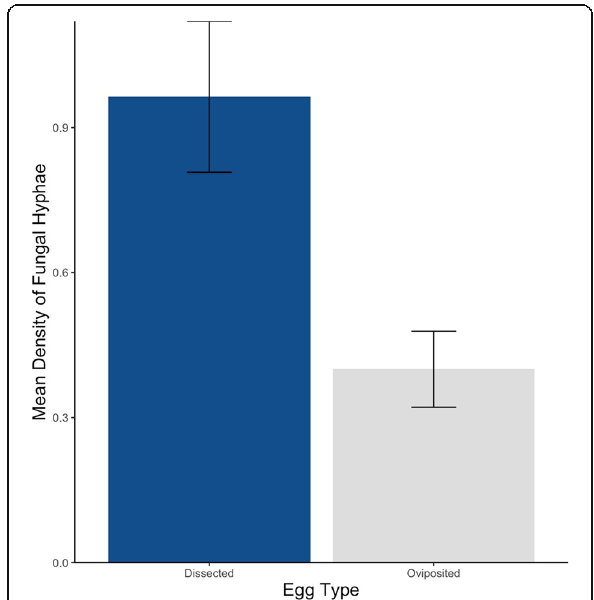
Fig. 3 Mean ( ± SE) density (per 1800 μ m 2 ) of fungal hyphae found on S. virgatus eggshells on Day 25 of incubation. The density of hyphae was significantly greater on dissected eggs than on oviposited eggs ( p = 0.008)